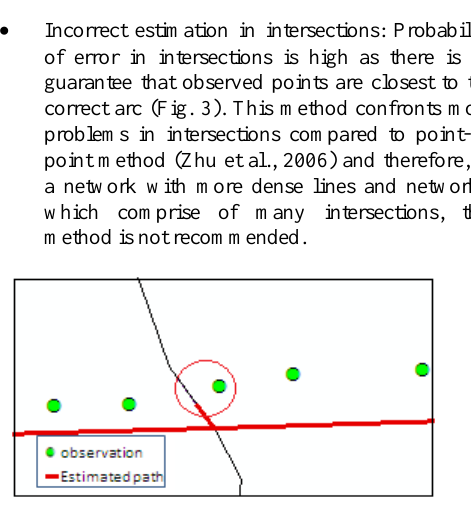
Figure 3. Weakness of point to curve method due to incorrect estimation in